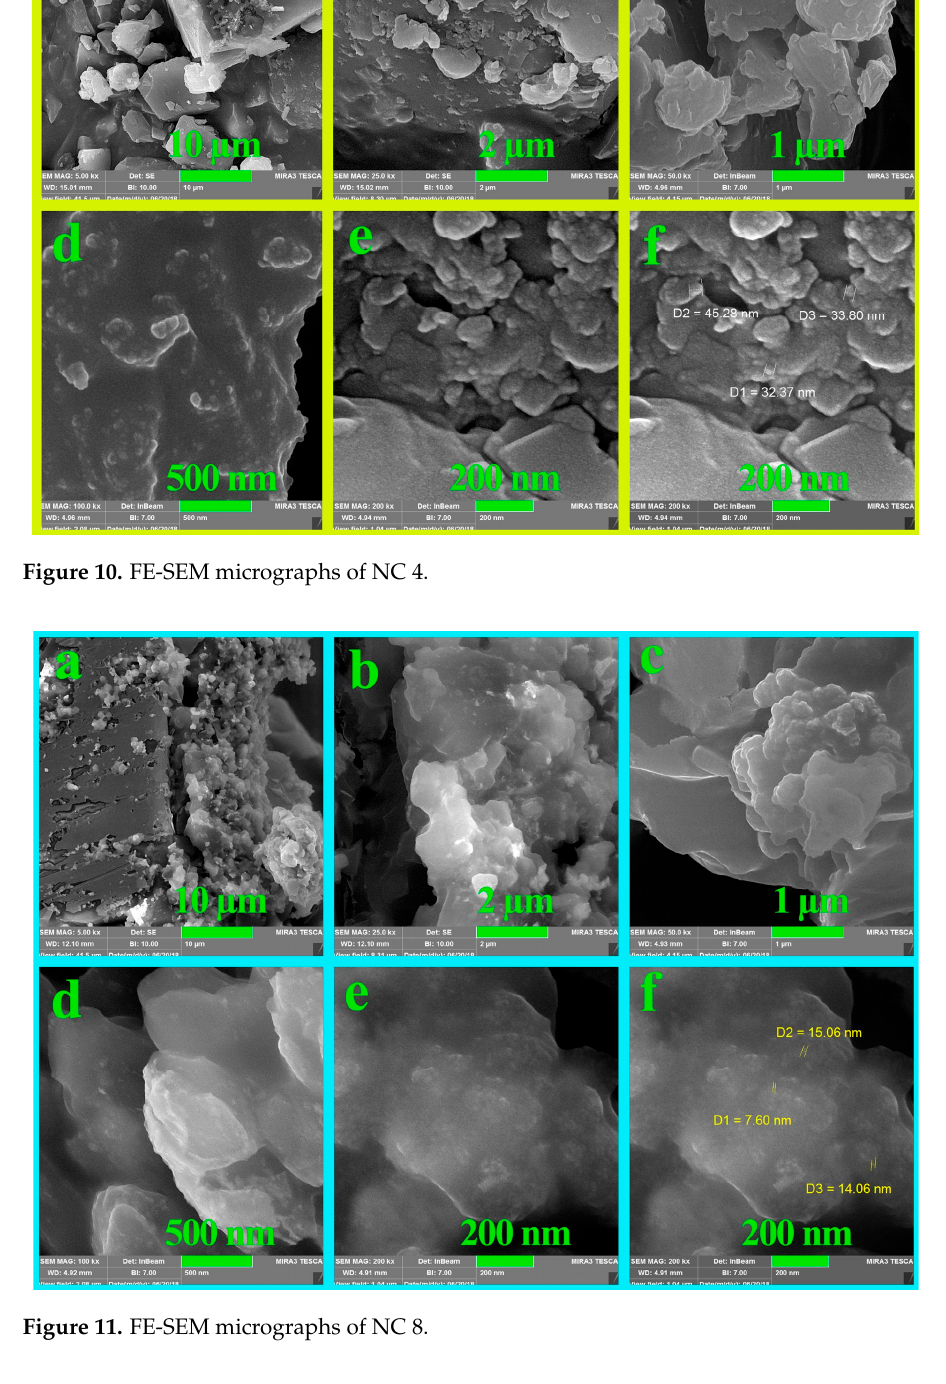
Figure 11. FE-SEM micrographs of NC 8.